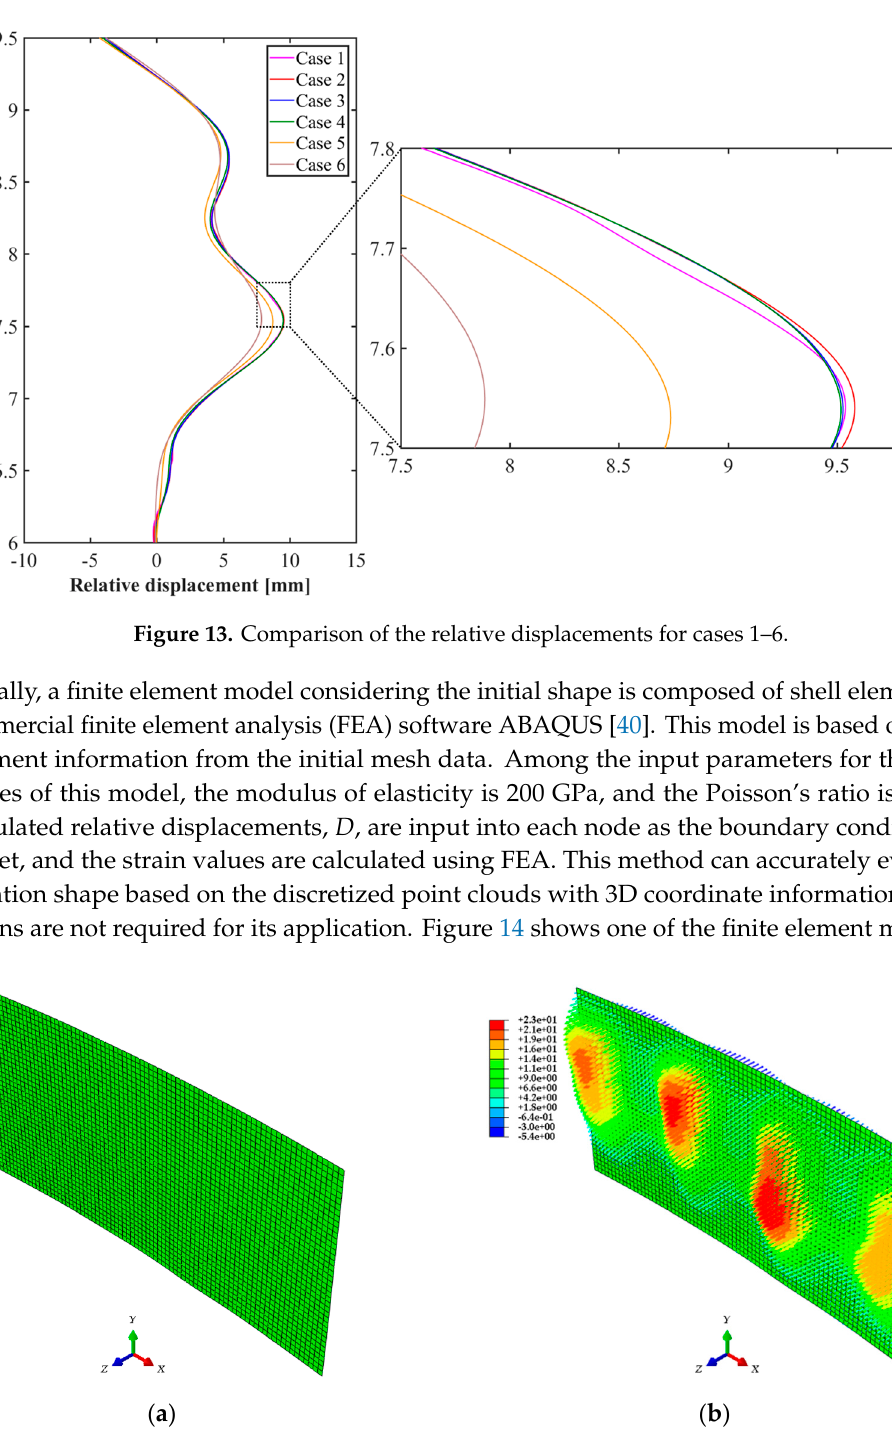
Figure 14. ABAQUS finite element model: ( a ) Initial model; ( b ) Model after inputting the relative displacements as boundary conditions [Unit: mm ].